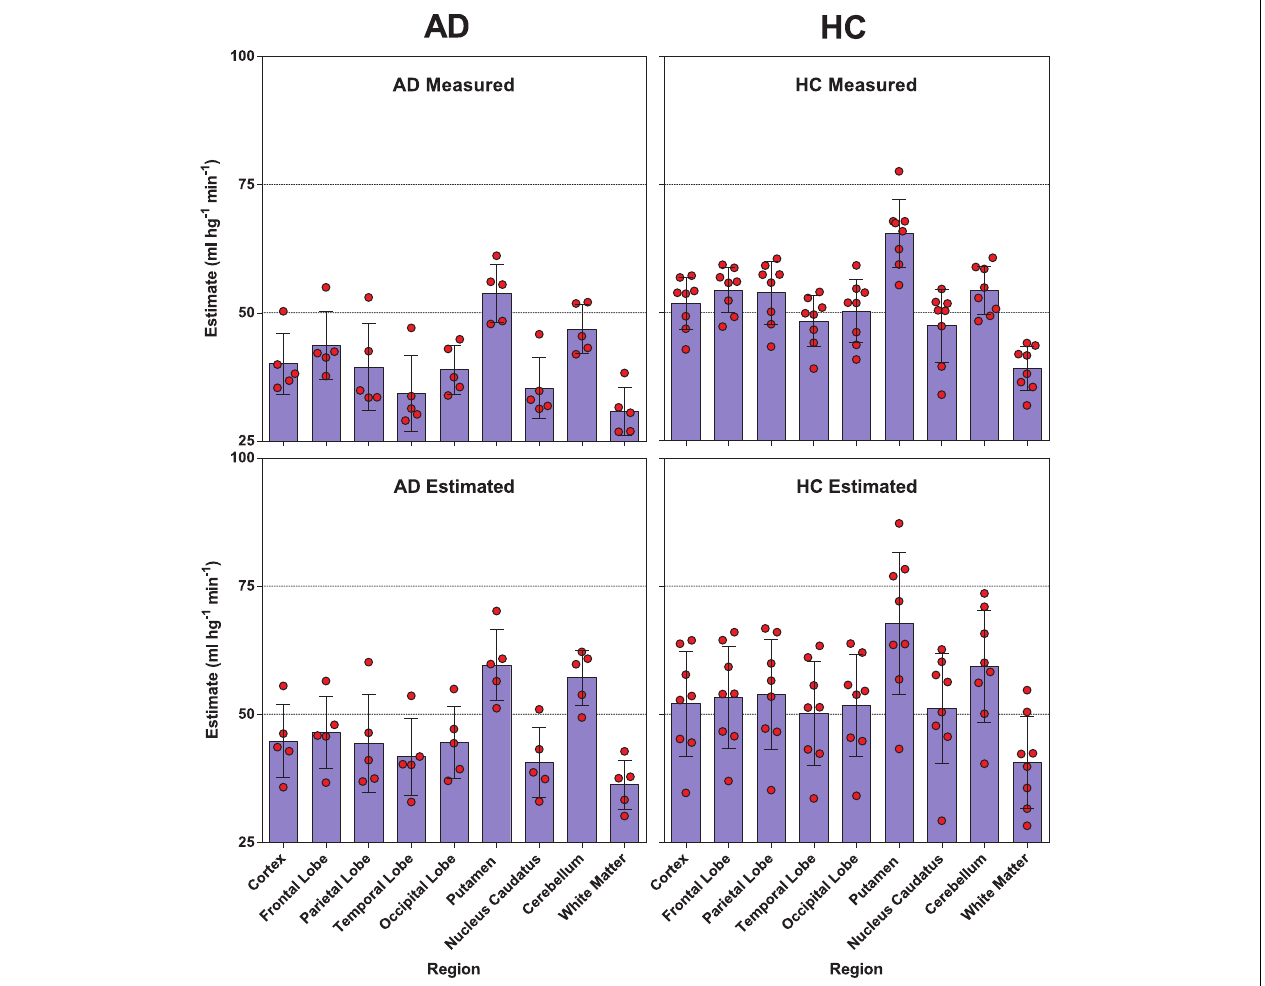
FIGURE 5 | Distribution and mean relationships between the [ 11 C ] PIB derived surrogate CBF values (lower panels) and the standard [ 15 O ] water derived CBF measures (upper panels) for selected regions in healthy controls (left panels) and AD patients (right panels).